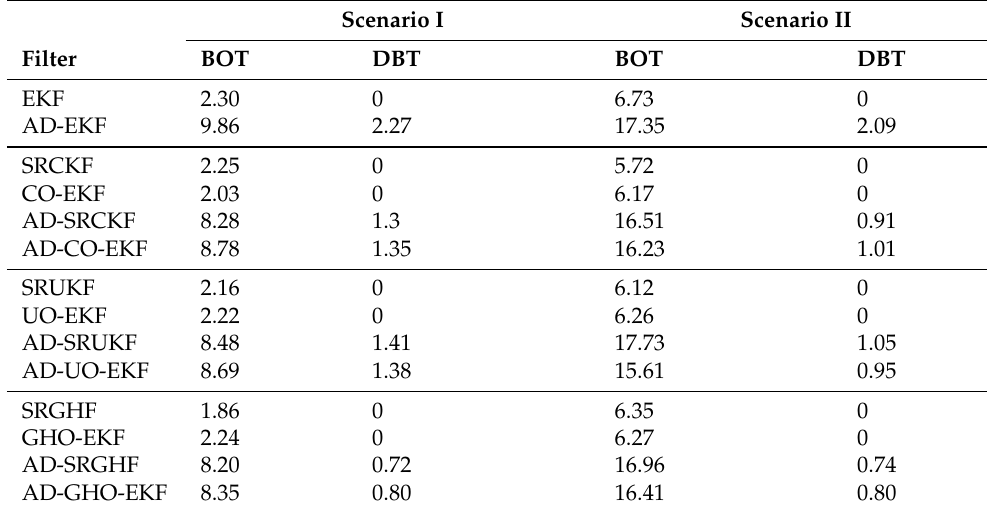
Table 3. Percentage track loss of different filters of the BOT and DBT for both scenarios. Scenario I